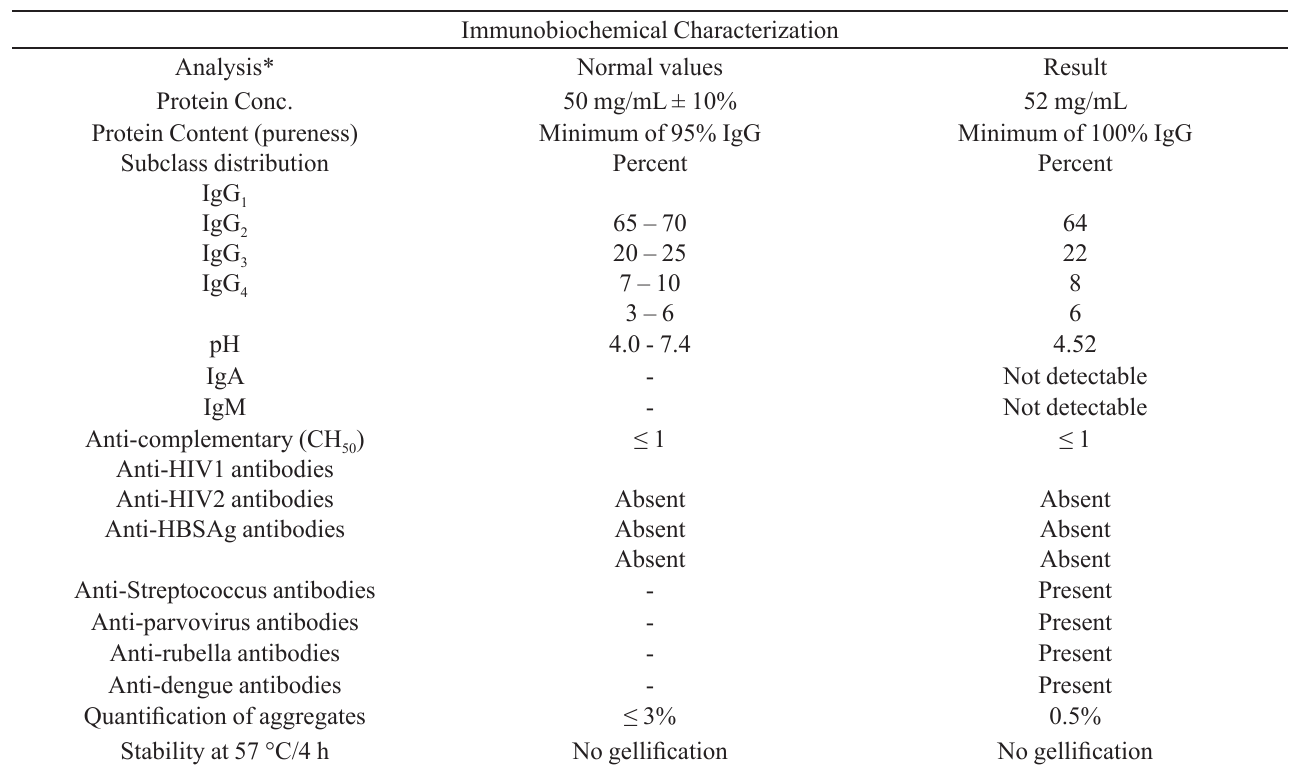
TABLE I - Biochemical/Immunological Characterization of 5%. IgG IV solution Immunobiochemical